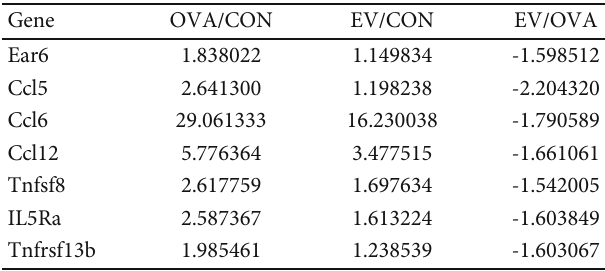
Table 1: Genes downregulated following treatment with ASC- derived EVs.